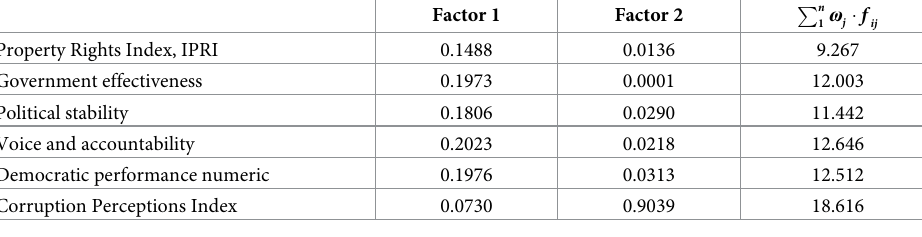
Table 6. The contribution of political and institutional variables to each factor.